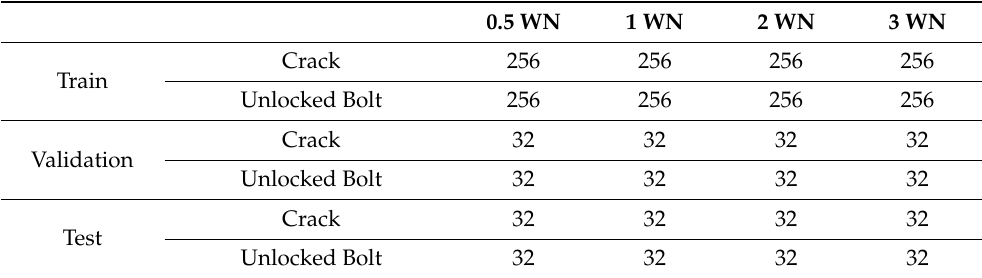
Table 4. Number of images used in the train, validation, and test sets per white noise (WN) amplitude factor and per studied class for damage